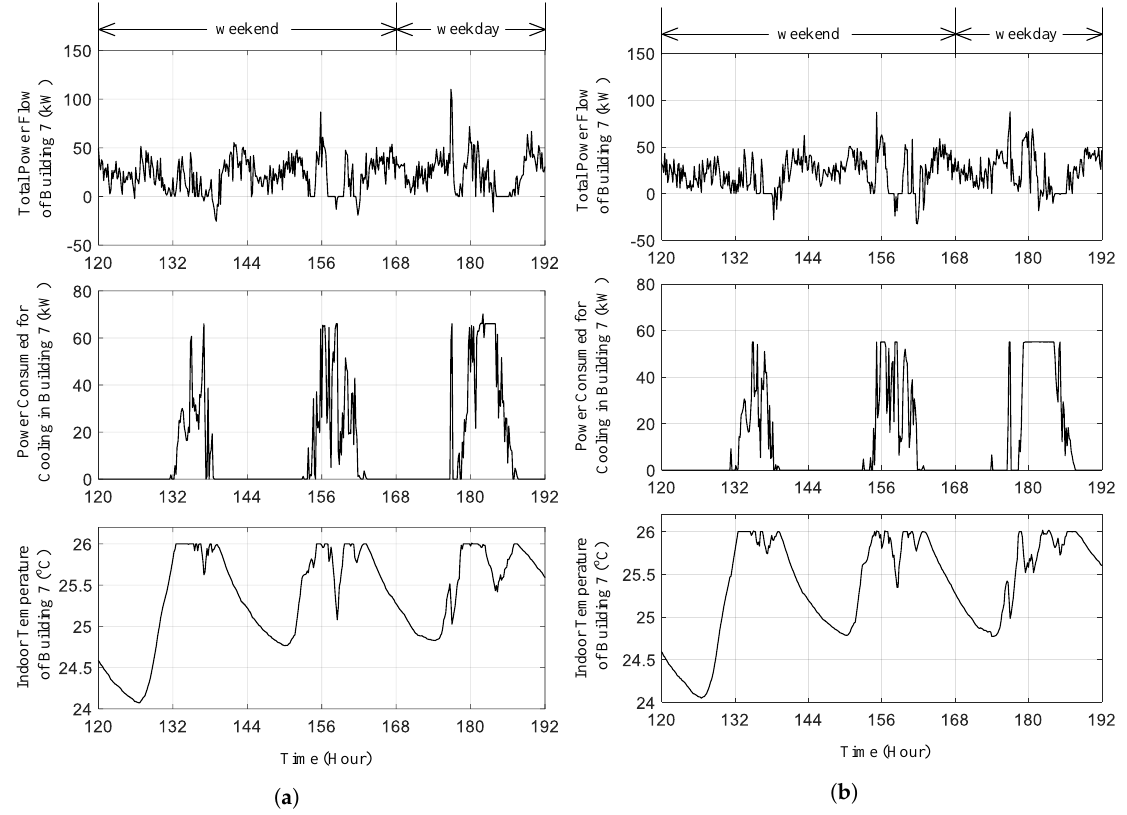
Figure 7. Response of building 7: ( a ) without dissipativity based coordination; ( b ) with dissipativity based coordination.